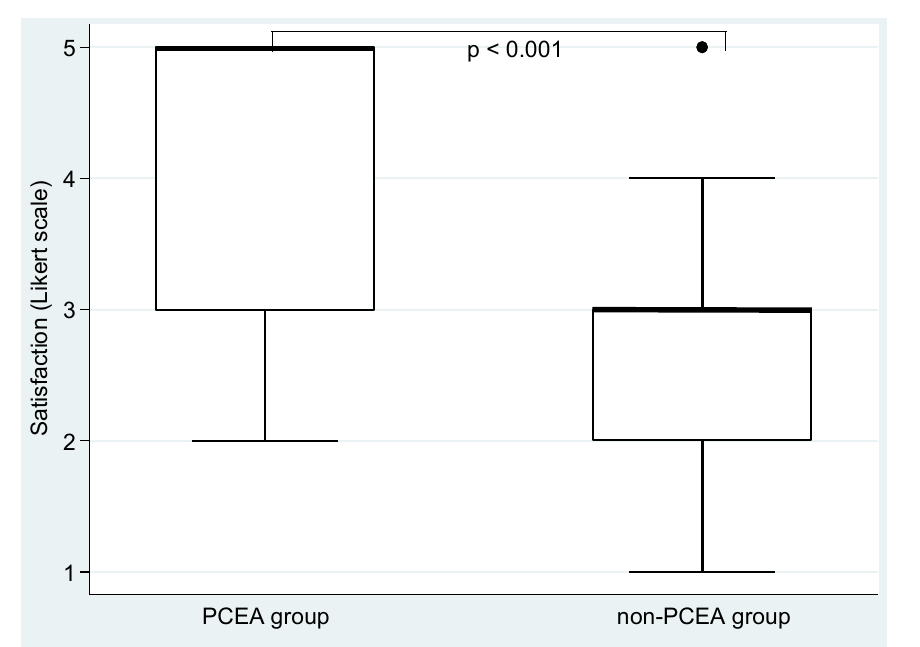
Fig. 3. Comparison of patient satisfaction between the PCEA and non-PCEA group. PCEA, patient-controlled epidural analgesia; non-PCEA, (conventional) non-patient-controlled epidural analgesia.